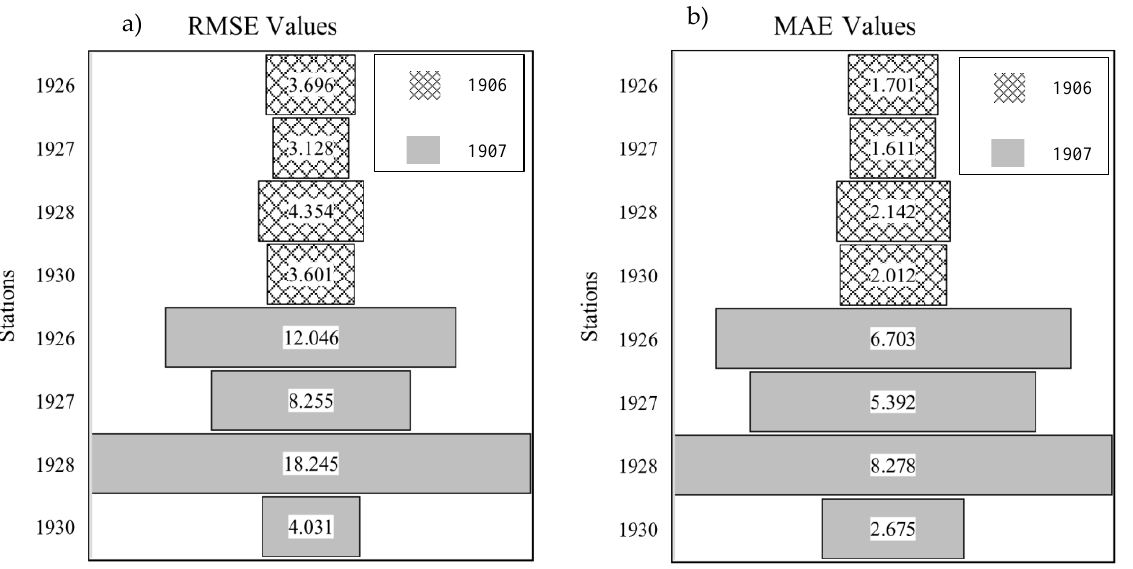
Figure 7. RMSE and MAE values in the transfer cases for applying bias correction. ( a ) RMSE results, ( b ) MAE results.